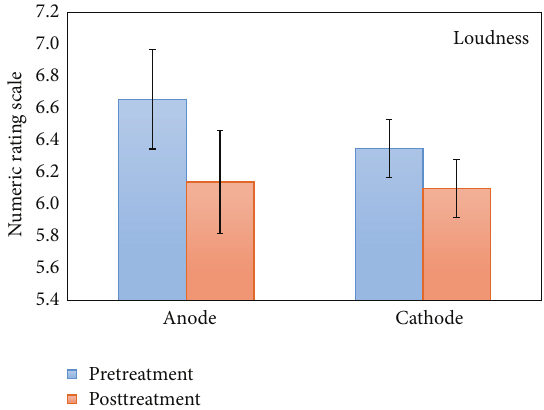
Figure 3: NRS loudness pre- and posttreatment (anodal and cathodal) for the 2.0 mA group.